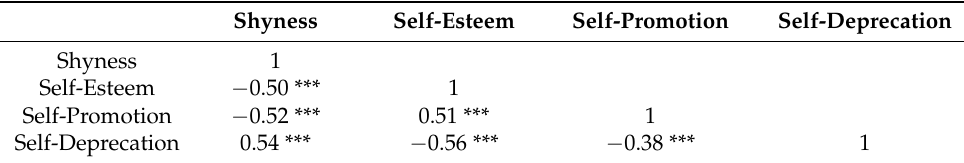
Table 2. Pearson correlation coefficients between the analyzed variables. Shyness Self-Esteem Self-Promotion